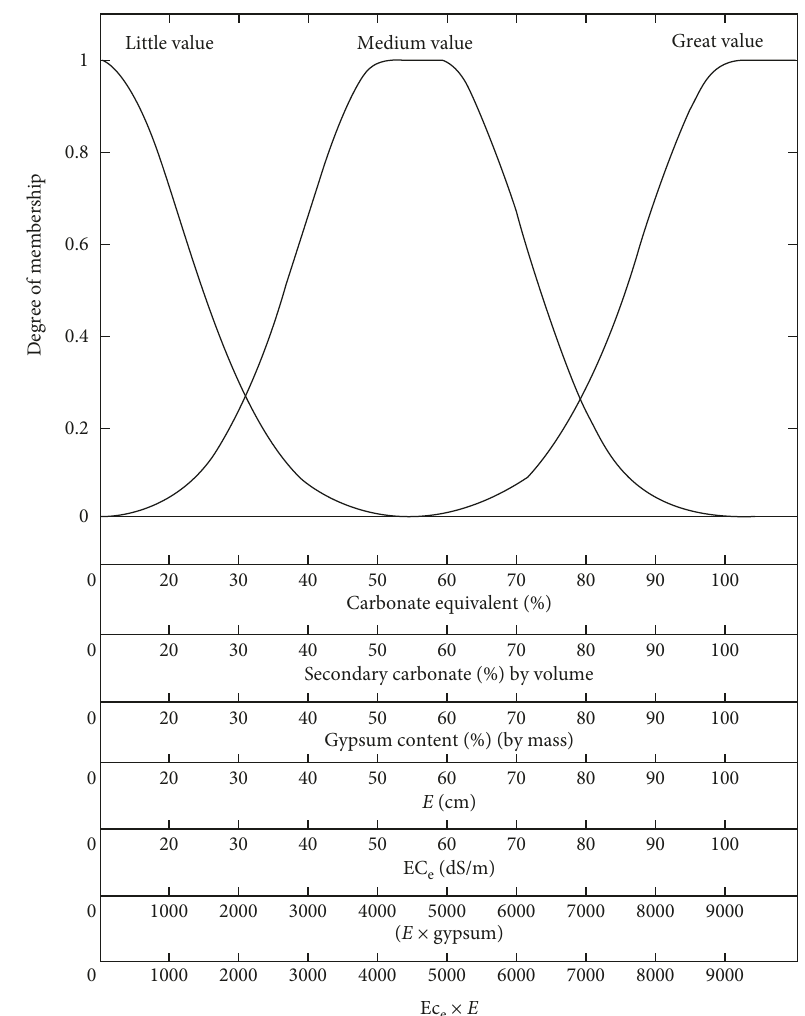
Figure 3: Membership function of input